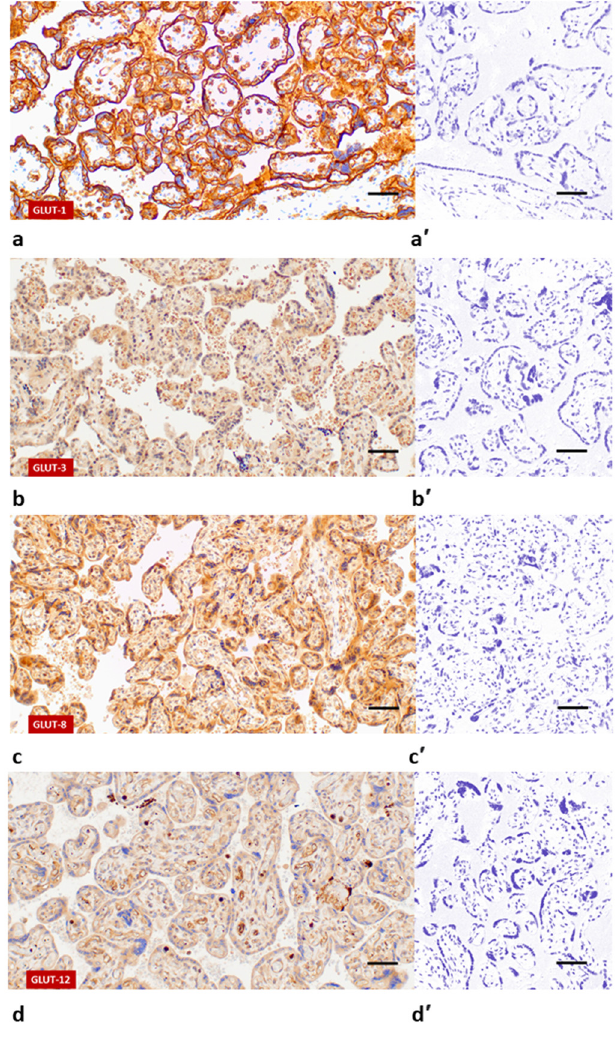
Figure 1. Immunohistochemical localisation of GLUT proteins in human term placenta: GLUT-1 ( a ); GLUT-3 ( b ); GLUT-8 ( c ); GLUT-12 ( d ). Images ( a’ ), ( b’ ), ( c’ ) and ( d’ ) represent respective negative controls. Scale bar = 50 µ